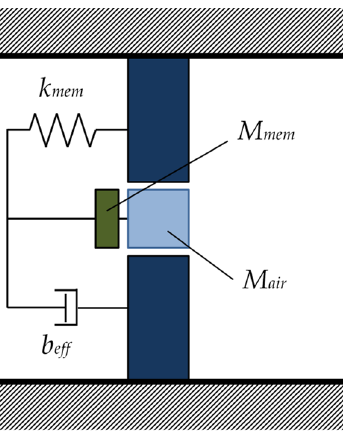
Figure 4. Analytical model for zero-mass metamaterials.